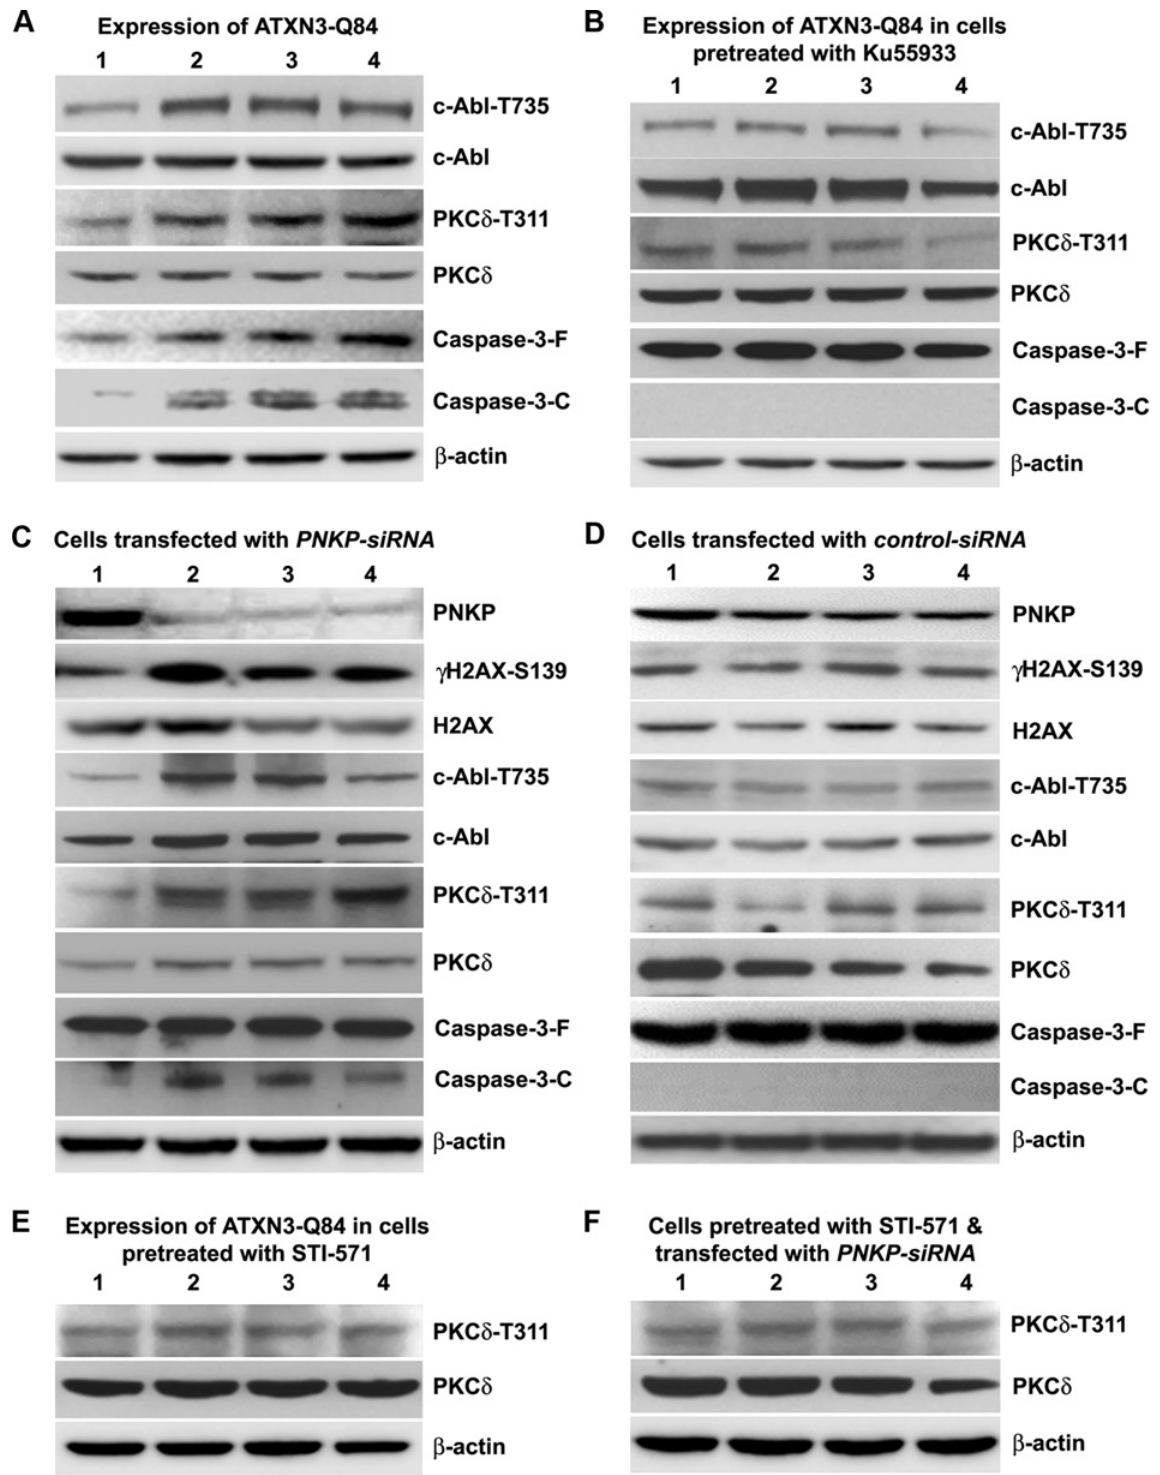
Figure 6. ATXN3-Q84 expression or PNKP deficiency activates the c-Abl ! PKC δ signaling pathway. (A) SH-SY5Y cells were differentiated, the expression of ATXN3-Q84 was induced, and cells were harvested 0, 3, 6 and 12 days post-induction (lanes 1 to 4). Cell lysates were analyzed by Western blotting to determine the levels of c-Abl-T735, total c-Abl, PKC δ -T311, total PKC δ , full-length caspase-3 (-F), and cleaved caspase-3 (-C); β -actin was used as a loading control in A to F. (B) SH-SY5Y cells were differentiated, and treated with the ATM inhibitor Ku55933, expression of ATXN3-Q84 induced, and